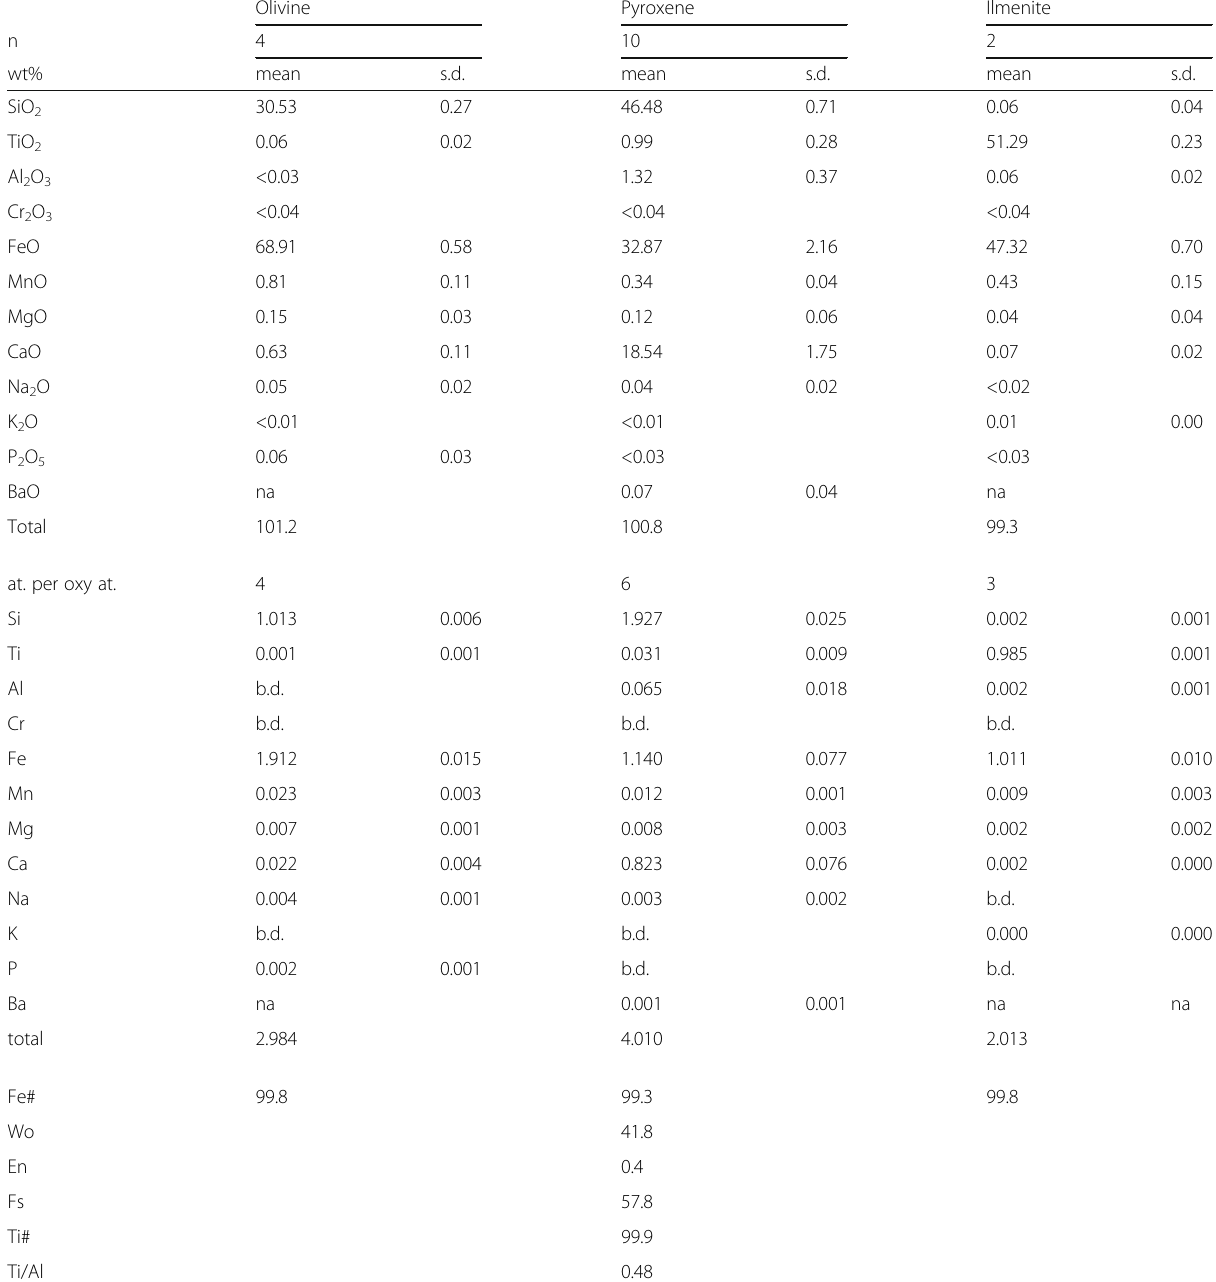
Table 2 Average compositions of olivine, pyroxene and ilmenite in the silicic clast Olivine Pyroxene